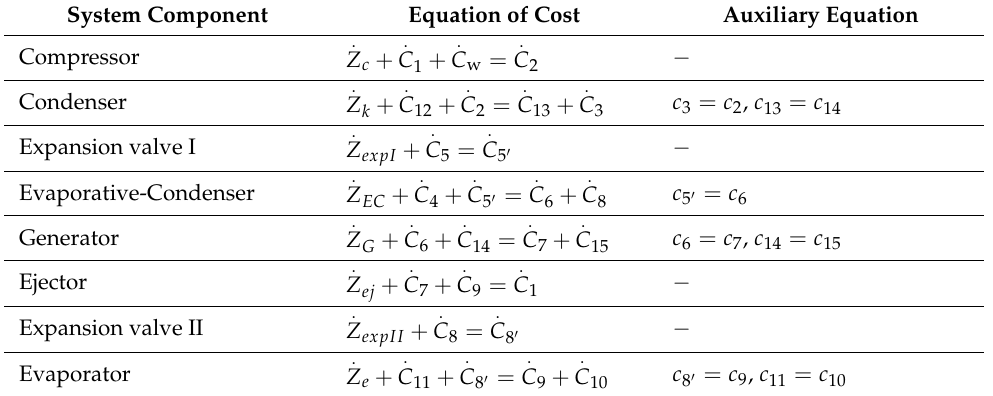
Table 5. Exergy cost equations for different